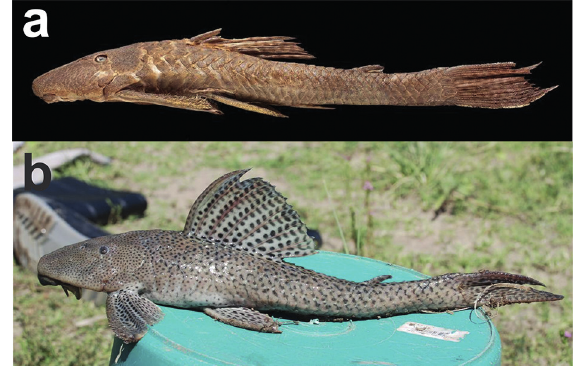
Figure 9 - Hypostomus cordovae : ( a ) holotype, BMNH 1878.4.4.1. Dorsal view. (Photograph: Natural History Museum, london); ( b ) Live specimen from Quinto River,